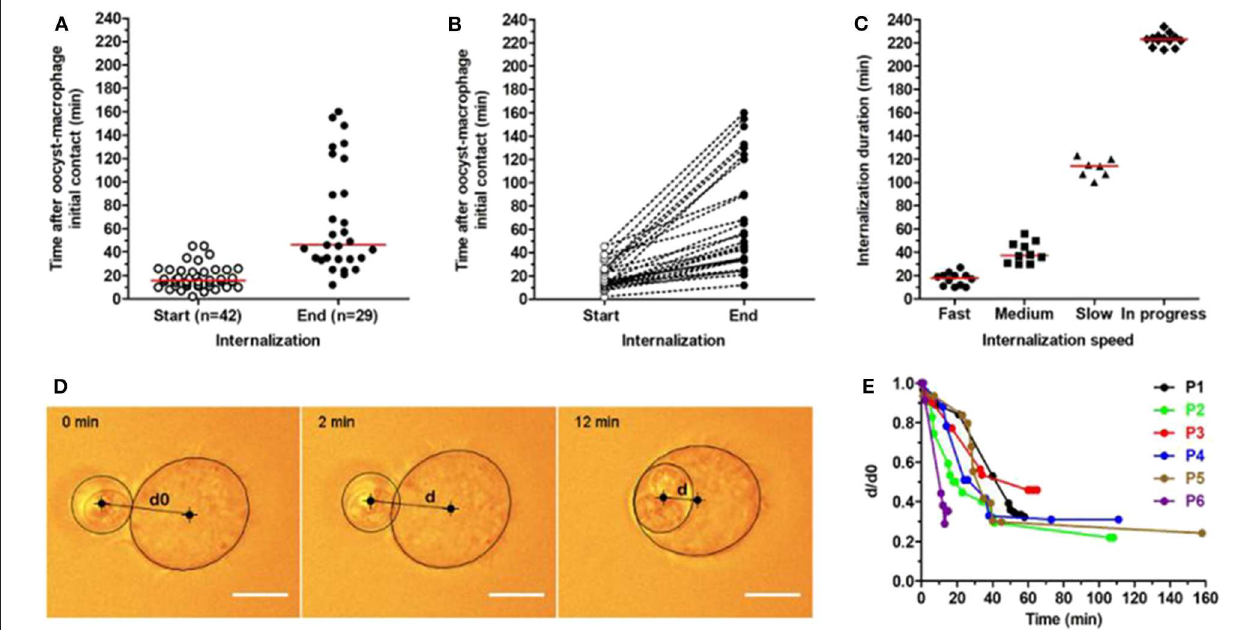
FIGURE 1 | Kinetics of T. gondii oocyst internalization by RAW macrophages measured using optical tweezers. Oocysts were trapped by optical tweezers and individually presented to macrophages. Each oocyst-macrophage pair was then followed for oocyst internalization by real-time imaging at 37 ◦ C for a maximum 240-min period. (A) Start and end of oocyst internalization after oocyst-macrophage initial contact (t0). The numbers of oocyst-macrophage pairs for which oocyst internalization started ( n = 42) and ended ( n = 29) within the 240-min period are indicated. Each dot represents an oocyst-macrophage pair. The red line represents the median of data distribution. (B) Distribution of oocyst-macrophage pairs ( n = 29) that completed oocyst internalization during the period and (C) the internalization speed. Speed was arbitrarily classified as fast (full internalization in 0–29min), medium (30–59min), slow ( ≥ 60min), and still in progress at the end of the experiments. Each symbol represents an oocyst-macrophage pair. The red line represents the median of data distribution. (D,E) Oocyst internalization dynamics was further characterized in 6 oocyst-macrophage pairs (P1 to P6) by quantifying d/d0 up to 160min following contact, with d0 the apparent distance measured between the oocyst and macrophage centers at t0 (initial contact) and d the apparent oocyst-macrophage distance at t > 0. A zoom on the 0–60min period is available in the Supplementary Figure 1 . Scale bar = 10 µ m.